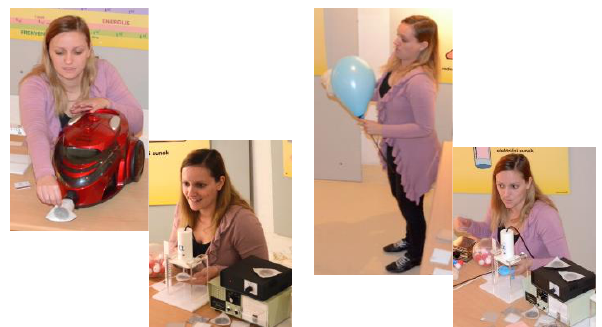
Fig. 9. Demonstration of radon progeny with filter and vacuum cleaner (left) and toy balloon (right).